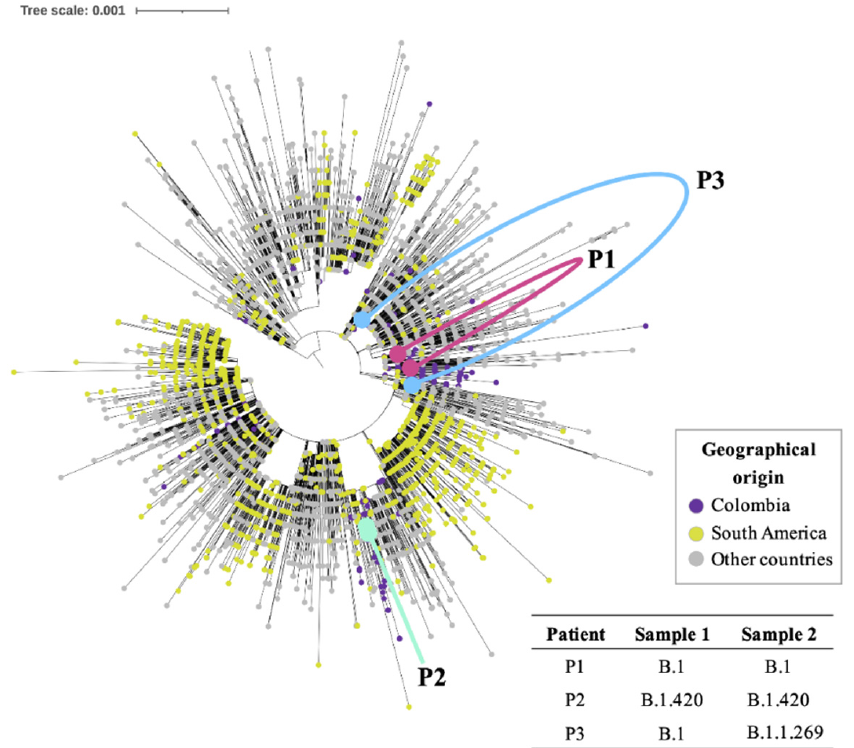
Figure 2. Phylogenomic reconstruction of the six genomes sequenced in this study compared to the 4171 genomes encompassing the global diversity of SARS-CoV2. The red dots and lines represent Patient 1 (persistence); the turquoise dots and lines represent Patient 2 (persistence); and the blue dots and lines represent Patient 3 (reinfection).